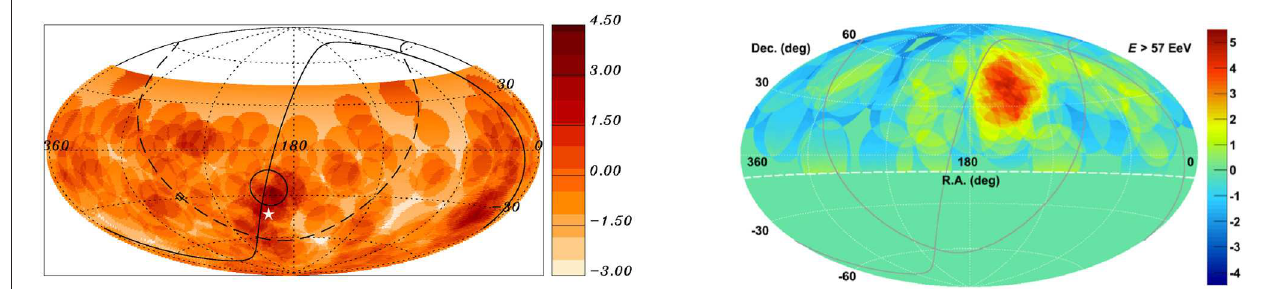
FIGURE 2 | Local-significance maps from searches for localized UHECR excess in equatorial coordinates. Left: Southern sky observed at E Auger > 54EeV smeared on a 12 ◦ angular scale. The solid and long-dashed lines indicate the supergalactic and Galactic plane, respectively. Reproduced with permission from Aab et al. (2015d). Right: Northern sky observed at E TA > 57EeV smeared on a 20 ◦ angular scale. Reproduced with permission from Abbasi et al.